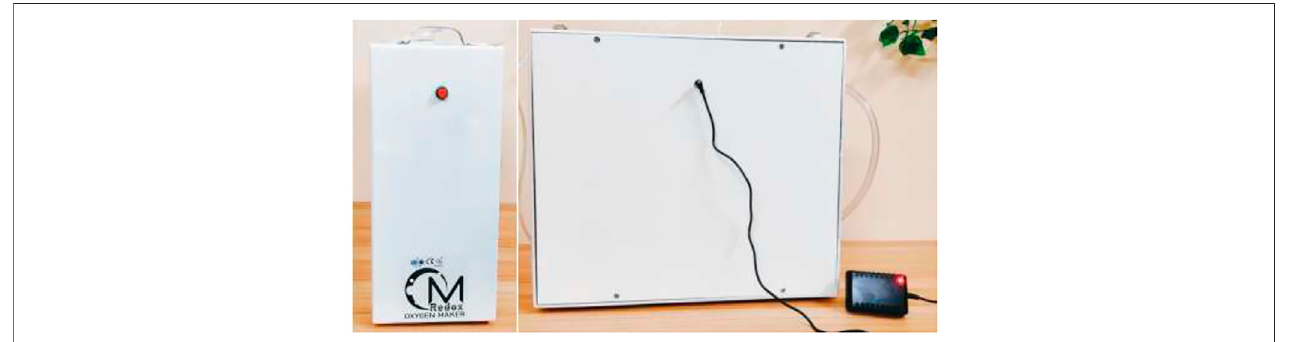
FIGURE 10 | Product oxygen maker, OM REDOX; the left and right sides present the front and side view of the